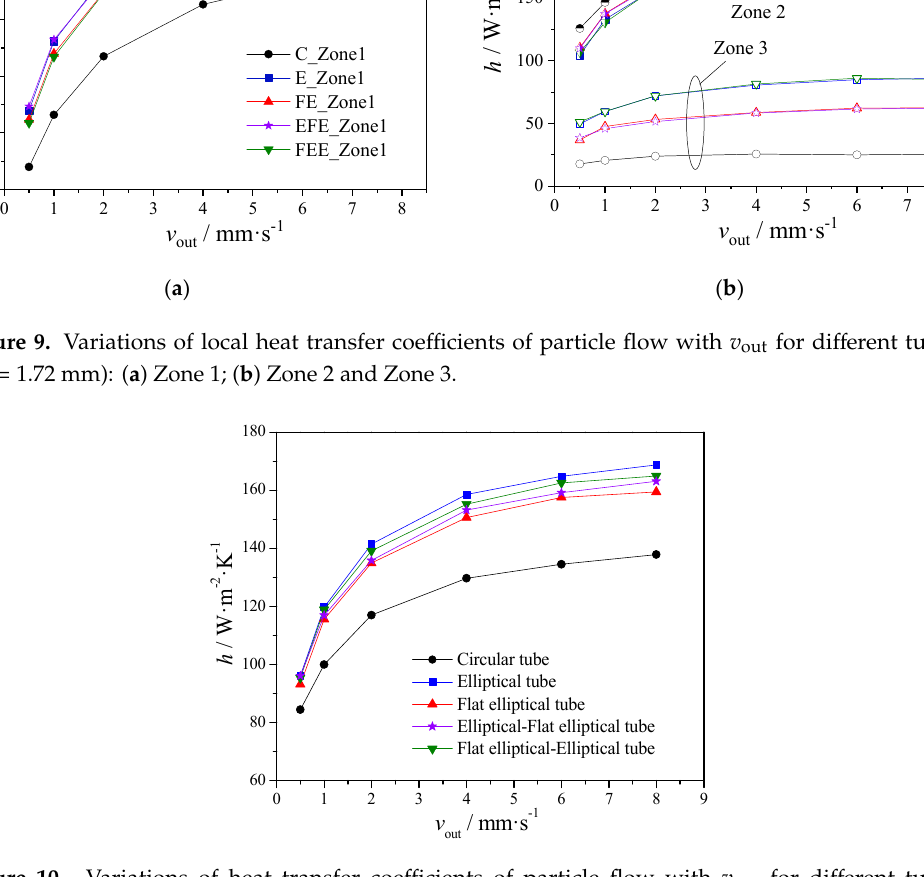
Figure 10. Variations of heat transfer coefficients of particle flow with v out for different tubes ( d p = 1.72 mm).